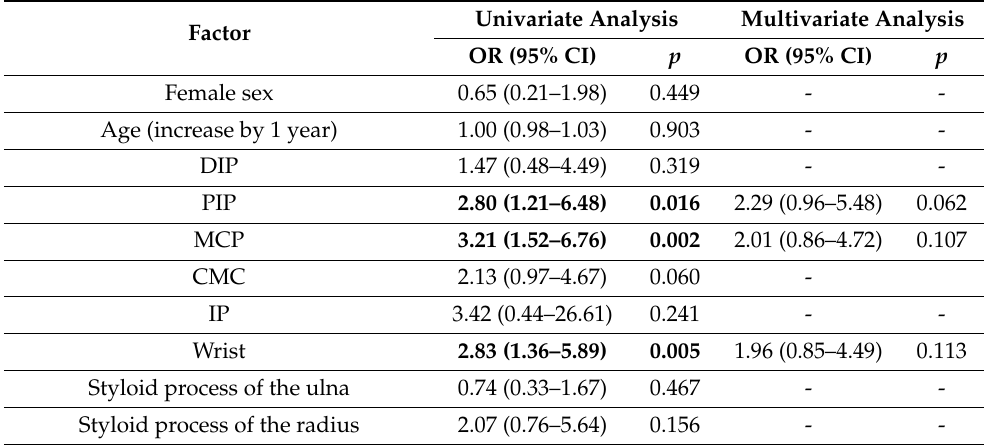
Table 9. Logistic regression for the dependent variable of seropositive RA vs. the independent variable of seronegative RA considering the location of the lesions.